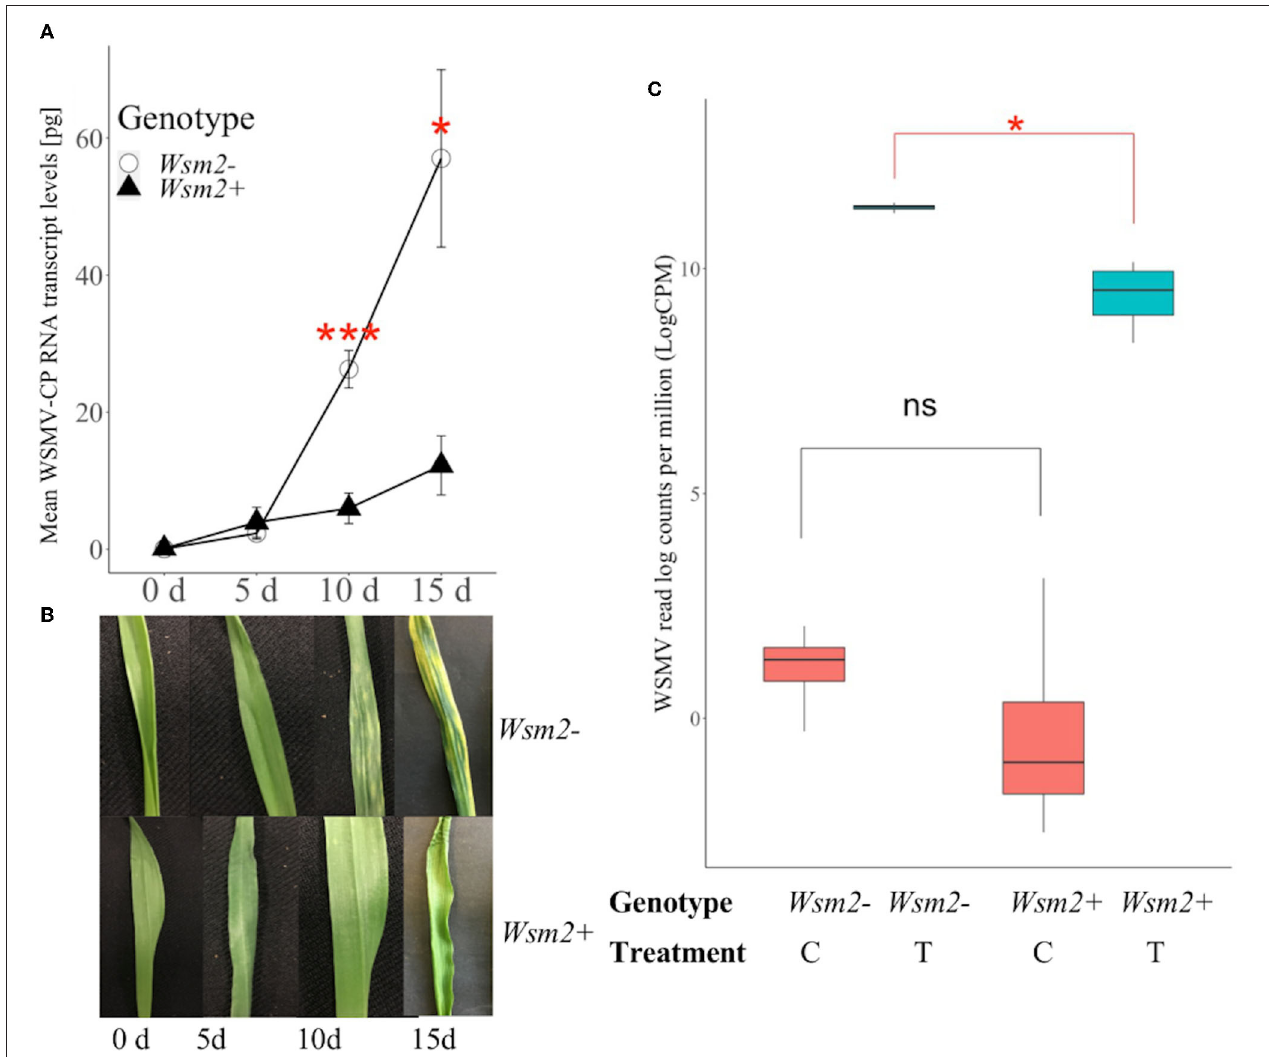
FIGURE 4 | Characterization of the response of Wsm2 + and Wsm2 - genotypes to WSMV infection. (A) WSMV quantification in “Snowmass” ( Wsm2 + ) and “Antero” ( Wsm2 -) leaf tissue before (0), 5-, 10- and 15- day post inoculation (dpi). Error bar indicates standard error (SE, n = 5). (B) Phenotype of leaves in “Snowmass” and “Antero” 0, 5, 10, and 15- dpi. (C) Quantification of WSMV reads (log counts per million) in RNA-seq samples ( n = 4) collected at 10 dpi from leaf tissue under four conditions: Wsm2 - (C), Wsm2- (T), Wsm2 + (C) and Wsm2 + (T), T indicates WSMV-treated condition, C indicates mock-treated condition. Two tailed t -tests were performed to compare genotypes. * P < 0.5, *** P < 0.001, ns = not significant.